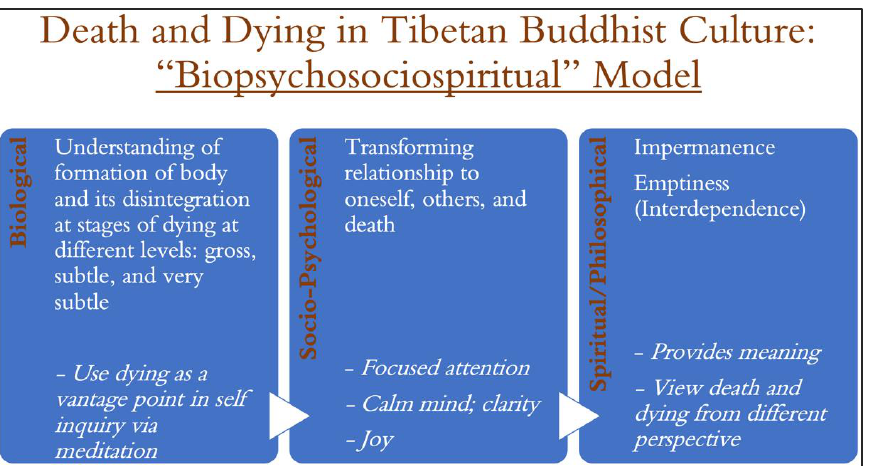
Figure 1. Tibetan Buddhist death model: the “biopsychosociospiritual” model.